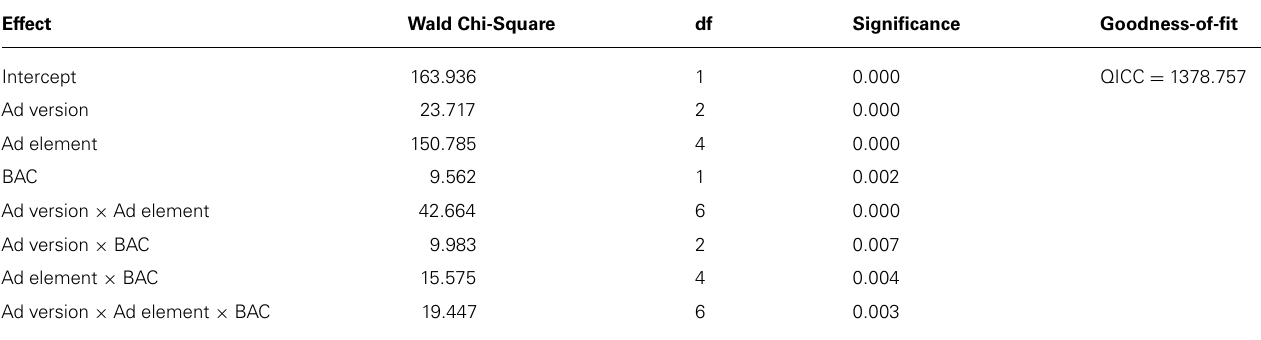
Table 3 | Effects of ad version, ad element and blood alcohol concentration on attention